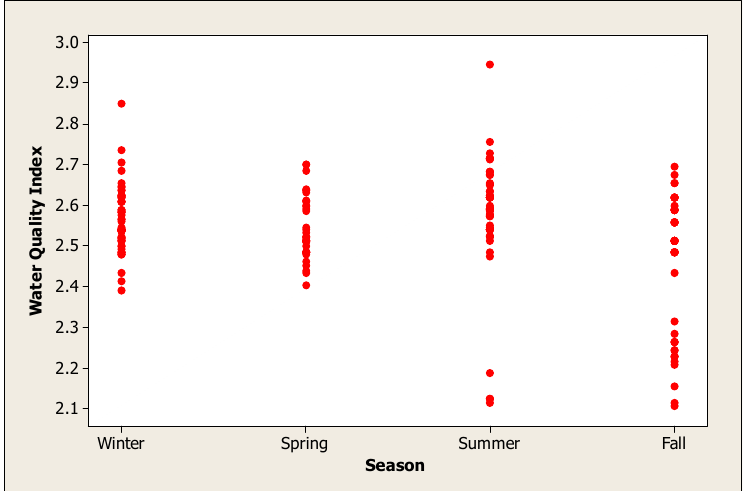
Figure 5. WQI values calculated for the fourth season in the Luis L. Dam in Chihuahua,